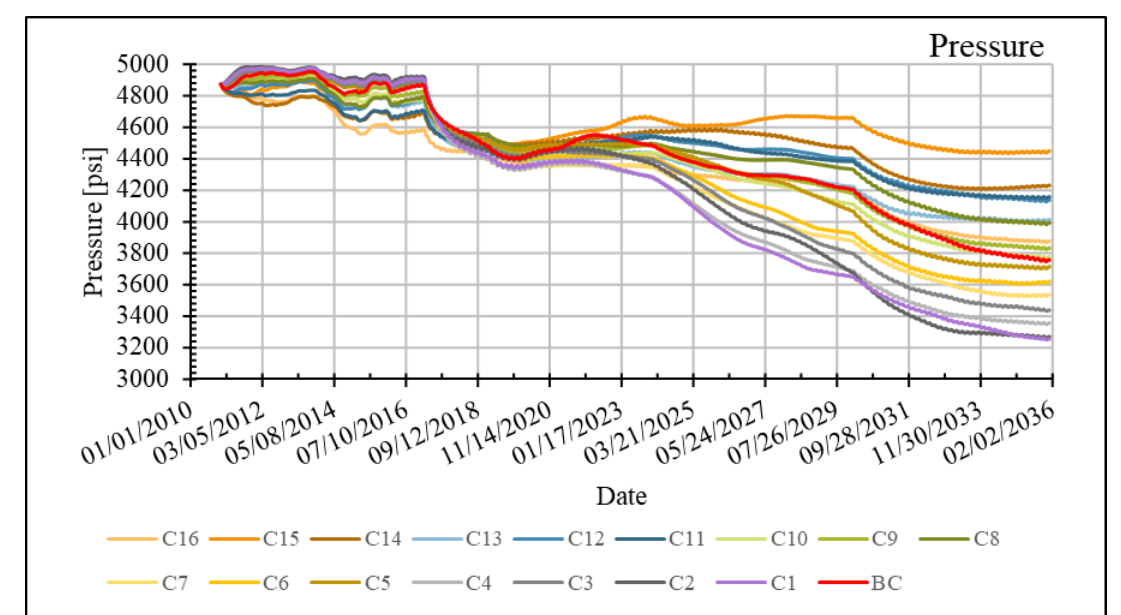
Figure 6. Pressure across the whole domain through time. The bold red line is the Base Case results.